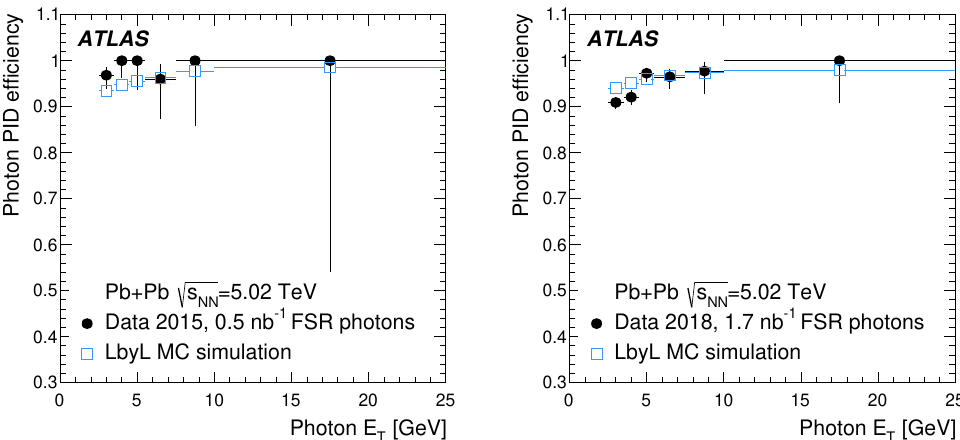
Figure 4 . Photon PID efficiency as a function of photon E T extracted from FSR event candidates in 2015 (left) and 2018 (right) data (full symbols) and signal MC sample (open symbols). The error bars denote statistical